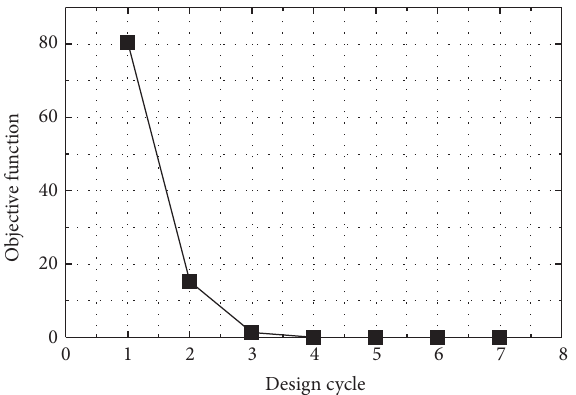
Figure 11: Variation of the objective function with the design cycles.